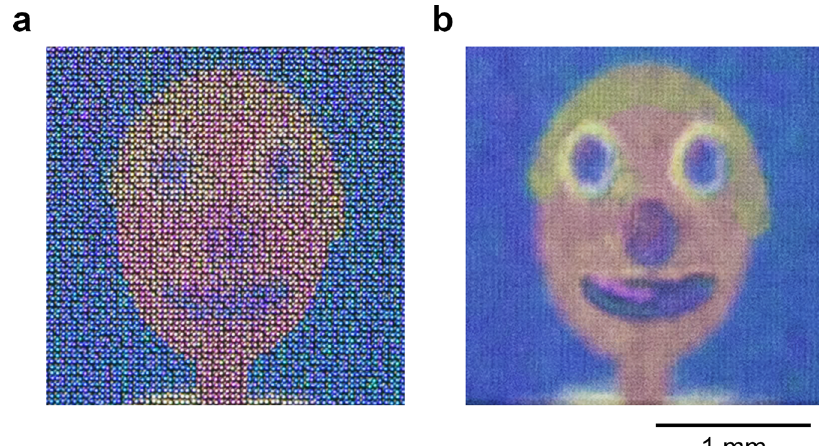
Fig. 6 Appearance of the light fi eld print captured at different focus distances. Digital camera macro images of the cartoon face were captured straight on from the central viewpoint (azimuthal angle α = 0° and elevation angle β = 0°). This light fi eld print was encoded with 15 × 15 different perspectives of the cartoon face, and each colour pixel comprised only a single nanopillar ~300 nm diameter (pixel pitch P = 1 µ m). a Image captured with the camera focused on the plane of the microlenses. b Image captured with the camera focused slightly in front of the microlenses, which also simulates what an observer sees. The same scale bar applies to both